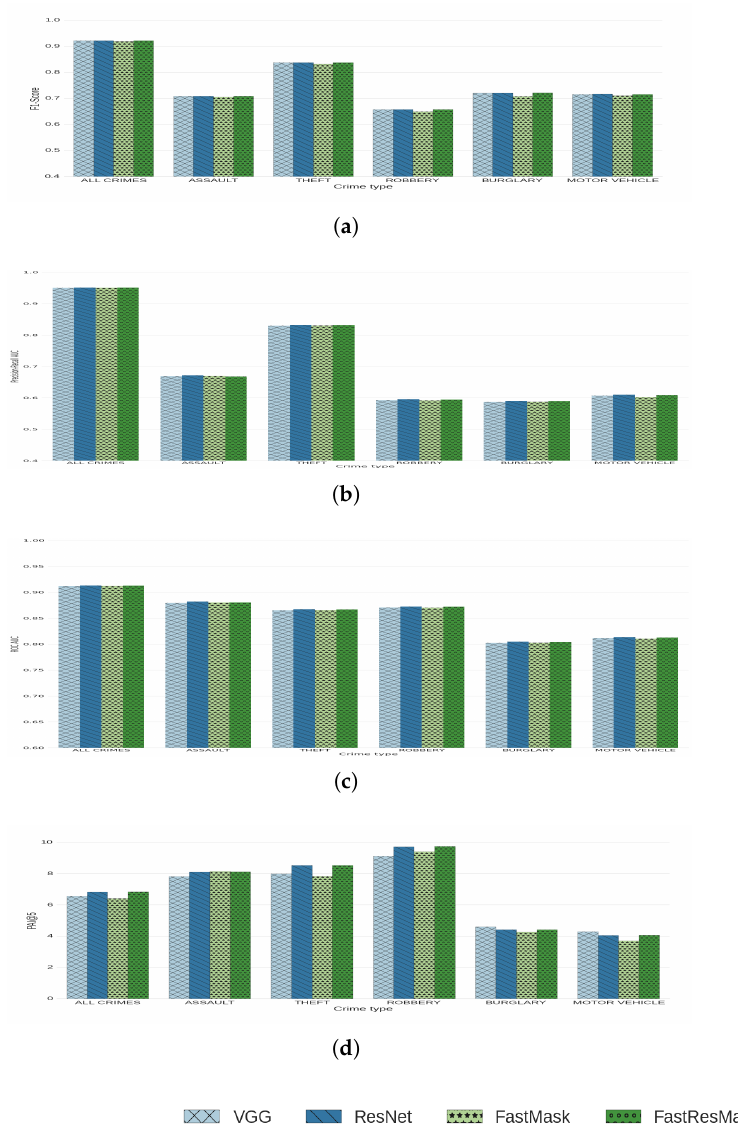
Figure 6. ( a ) F1score, ( b ) PR AUC, ( c ) ROC AUC and ( d ) PAI@5 per crime type in the Philadelphia dataset, for 4 spatial clue extractor bodies. Best viewed in